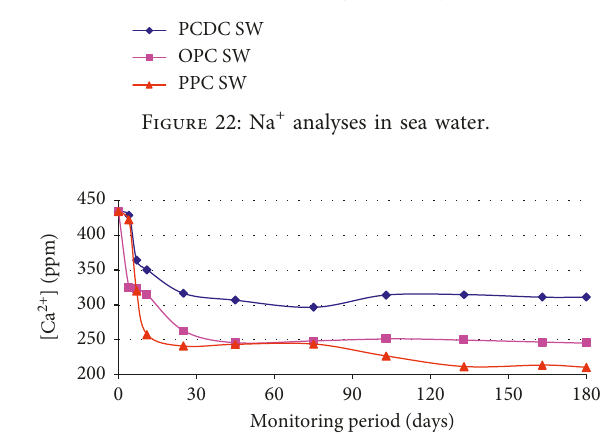
2 analyses in sea water. 4 −